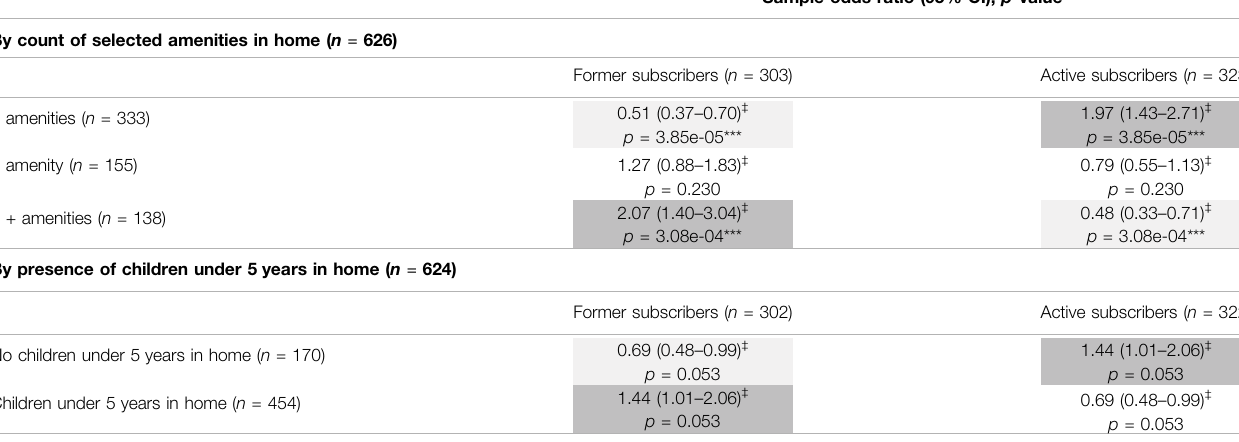
TABLE 2 | Subscriber status, by household